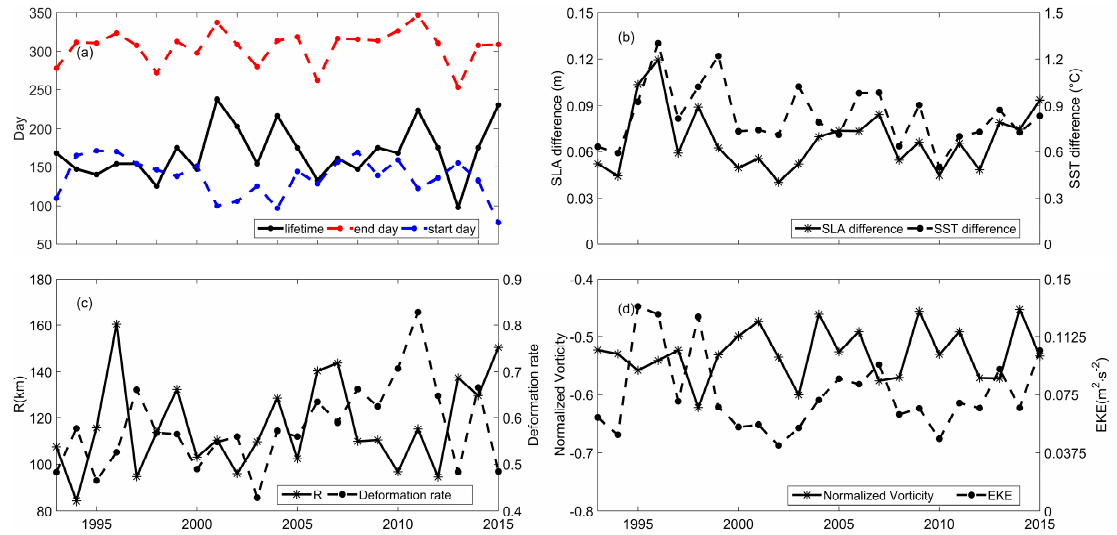
Figure 9. Time series from 1993 to 2015 of ( a ) the GW start time (blue dash line), end time (red dash line), and lifetime (solid line) (unit: day); ( b ) the SLA difference (solid line, unit: m) and the SST difference (dash line, unit: ◦ C) in the center of the GW; ( c ) radius (unit: km, solid line) and deformation rate (dash line) of the GW; ( d ) normalized vorticity (solid line) and eddy kinetic energy (EKE) (unit: m 2 · s − 2 , dash line) of the GW.